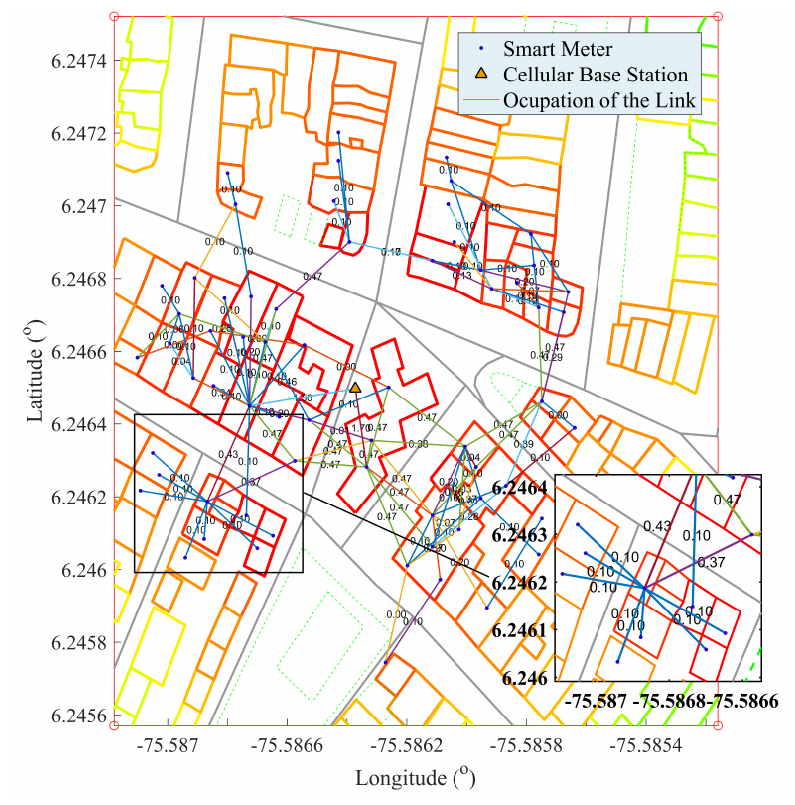
Figure 6. Use of the link (%) for each flow.